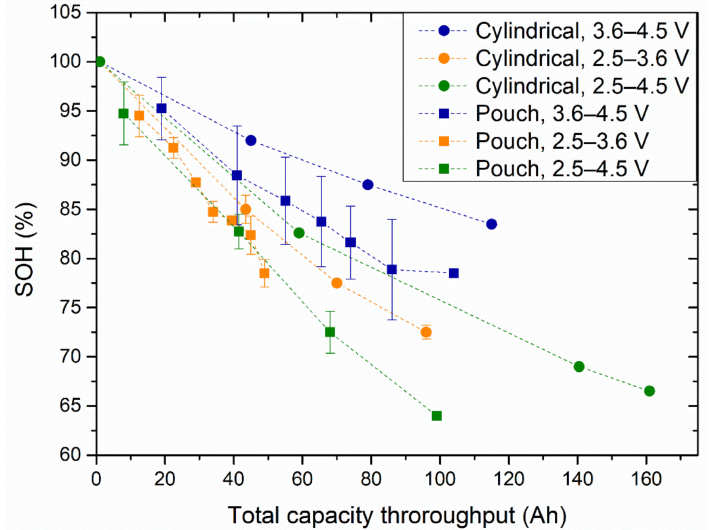
Figure 3. SOH evolution with the total capacity throughput for cylindrical (circle markers) and pouch (square markers) cells cycled in the 3.6–4.5 V (blue markers), 2.5–3.6 V (orange markers), and 2.5–4.5 V (green markers) voltage